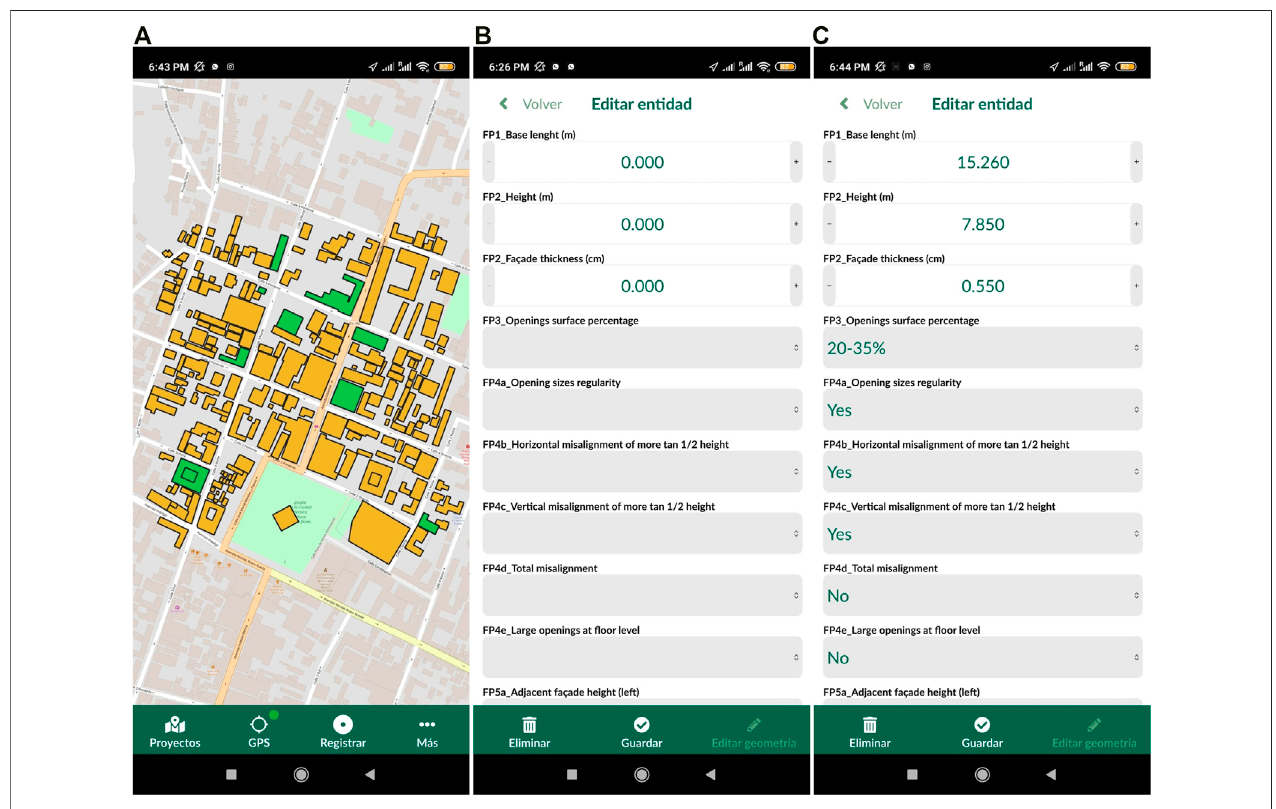
FIGURE2| ScreenshotsoftheuserinterfaceoftheInputapp.Theuserinterfacefacilitatesusingthedevice ’ sGPSlocalisation (A) toassociategeographicaldatato an attribute table where quantitative and qualitative vulnerability-related parameters are programmed (B,C) . Adapted from Eudave and Miguel Ferreira (2021).